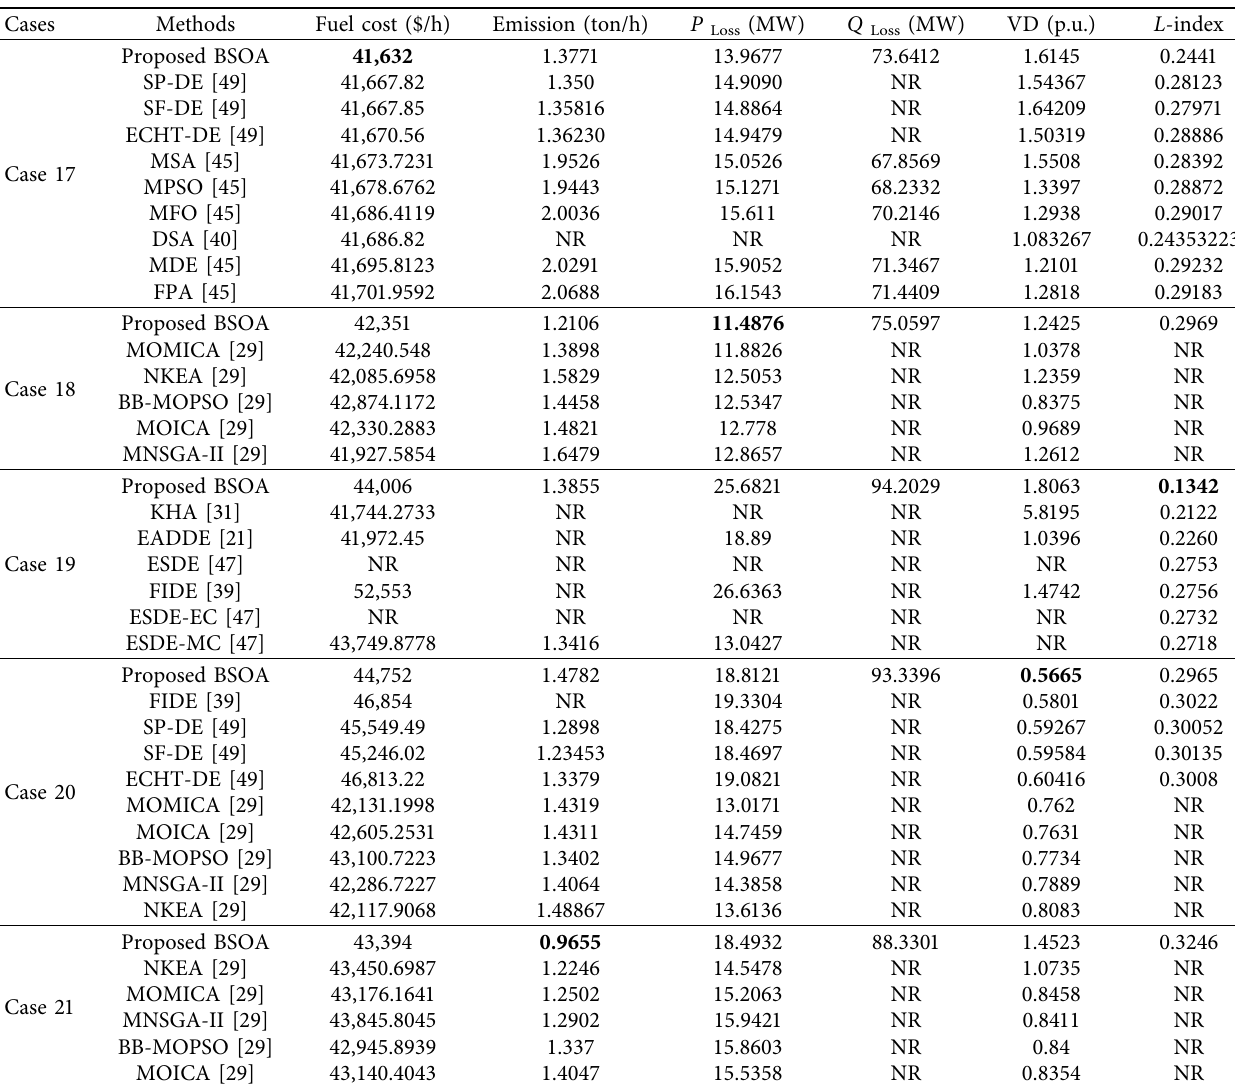
Te best objective values are highlighted in the bold text. Table 10: Comparison of proposed BSOA with previous recent studies of single-objective cases (Case 17 to Case 21) for the IEEE 57-bus